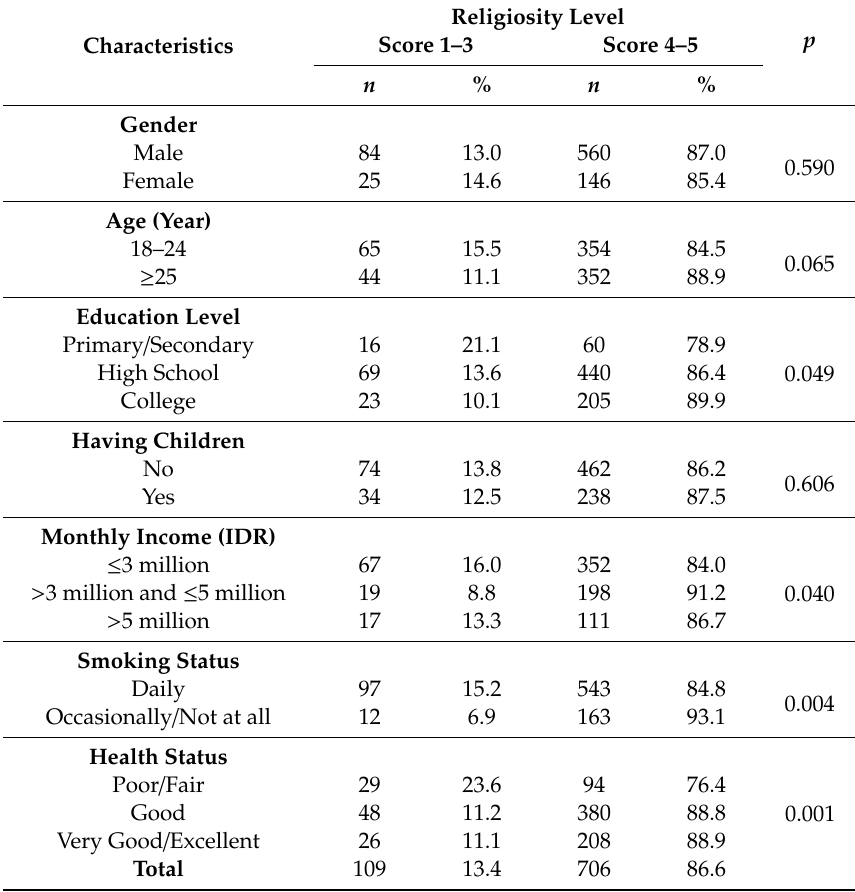
Table 2. Sociodemographic Characteristics of Participants by Religiosity